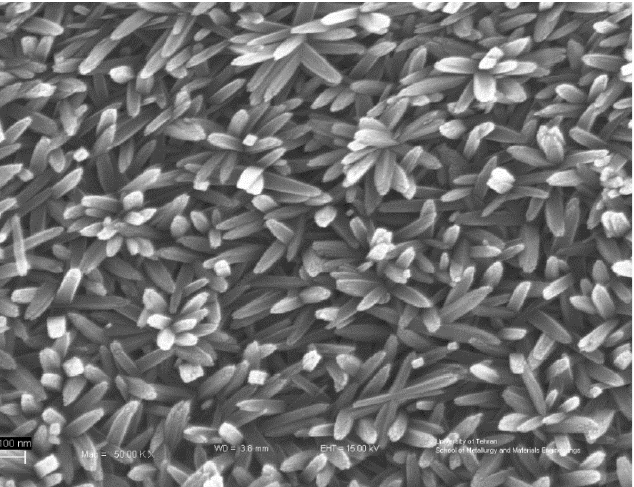
Figure 2. FESEM image of sample FeOOH thin film (Sample G17). A large number of flower ‐ like nano ‐ rods are formed on the substrate.